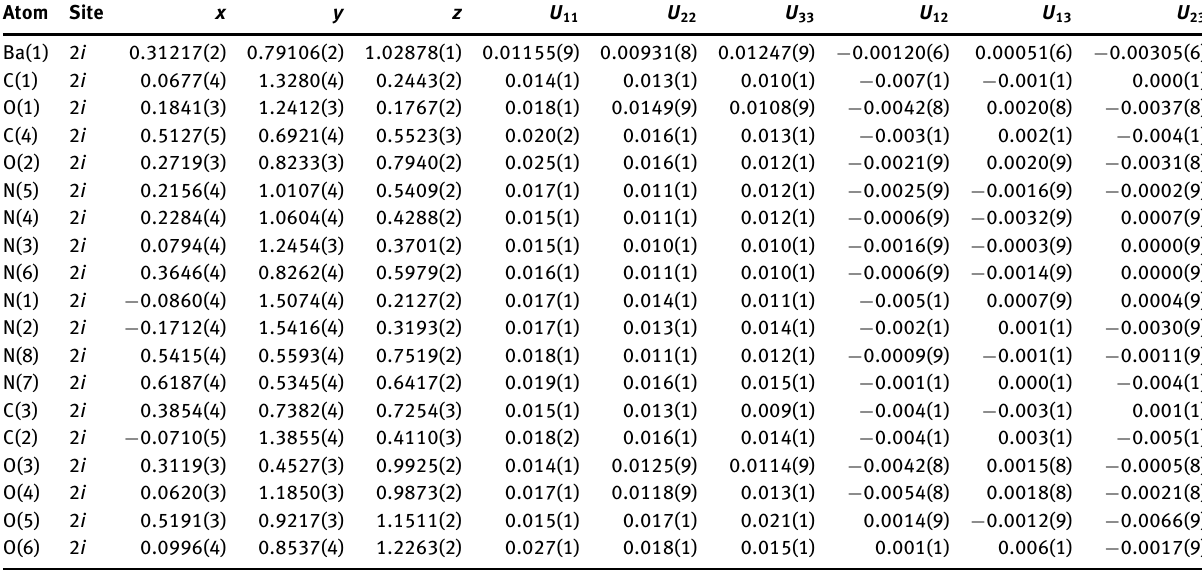
Table 3: Atomic displacement parameters (Å 2